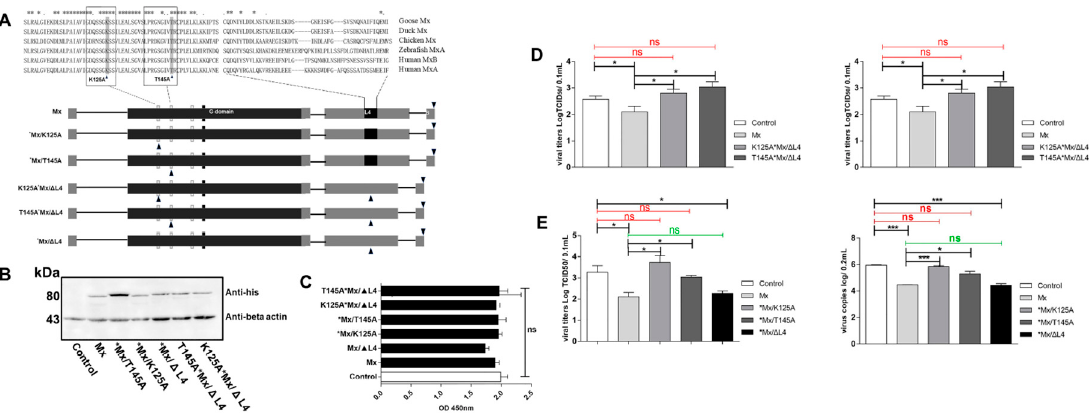
Figure 6. The antiviral determinants of goMx. ( A ) Construction of wild-type goMx and its variants, including the GTPase-deficient mutants, *Mx/K125A and *Mx/T145A, the *Mx/ ∆ L4 deletion plasmid, and two combination mutation plasmids of K125A*Mx/ ∆ L4 and T145A*Mx/ ∆ L4. The solid pillar stands for the Mg 2+ active domain, while the blank pillar represents the tripartite GTP-binding domain consisting of GxxxxGKS, DxxG, and TKxD. The black triangles mark the point and deletion mutations, while the inverted black triangles represent the His-tag. ( B ) Detection of His-tagged wild-type goMx and its variants using western blot analysis. GoMx proteins and beta-actin were analyzed with western blot using an anti-His monoclonal antibody and anti-beta-actin antibody, respectively. The polyvinylidene fluoride (PVDF) membrane incubated with the goat-anti-mouse secondary antibodies. ( C ) Cell viability analysis of goMx and its variant protein in GEF. CCK8 assays of indicated plasmids were performed in triplicate. ( D ) The antiviral activity of goMx and its variants, K125A*Mx/ ∆ L4 and T145A*Mx/ ∆ L4, completely abolished antiviral activity. Transiently transfected GEF-expressing His-tagged Mx or its variant proteins, K125A*Mx/ ∆ L4 and T145A*Mx/ ∆ L4, were infected with 100 µ L of 1000 TCID 50 TMUV per cell, then the cells were collected by three-cycle freezing and thawing, using a volume of 500 µ L PBS at different time points (24, 48, and 72 hpi). The inhibition ability of TMUV was determined by TCID 50 and viral copy tests. Results are presented as means of technical duplicates of three independent experiments. ( E ) The antiviral activity of Mx and its variants. The K125 and T145 amino acids in the GTPase domain could account for deficient antiviral activity. Antiviral activity of the single substitution of *Mx/T145A and *K/125A or deletion *Mx/ ∆ L4 was assessed by TCID 50 and viral copy tests. The statistical analysis was performed in GraphPad Prism using unpaired two-tailed t -tests: “ns” means no significance (the red “ns” is compared to the control, and the green “ns” is compared to the wild-type Mx as the experimental positive group; * p < 0.05; *** p <